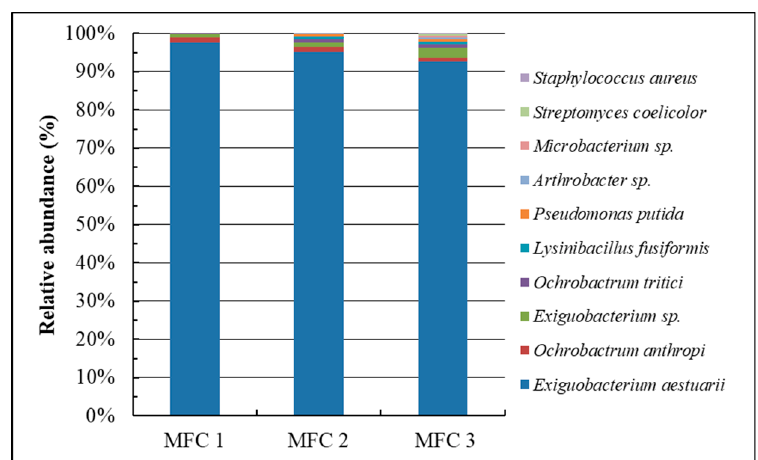
Figure 7. Relative abundances of the bacterial 16S rRNA gene sequences in the biofilm of three-stage SCMFC biosensor after measuring the Cr(VI) concentration from the effluents of eight leather processing units.